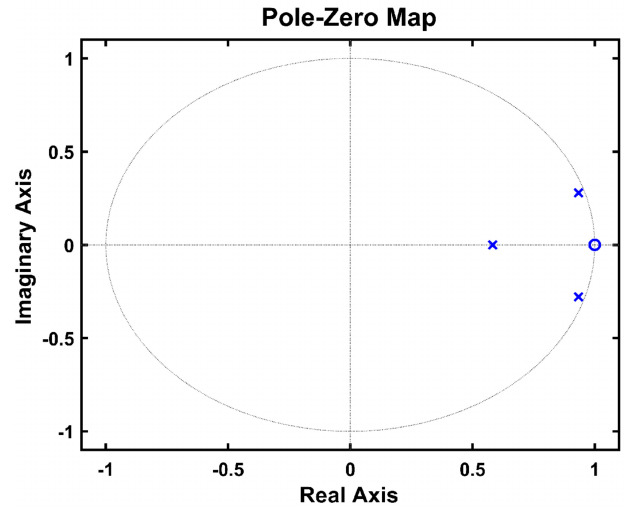
Figure 18. Pole–zero plot.